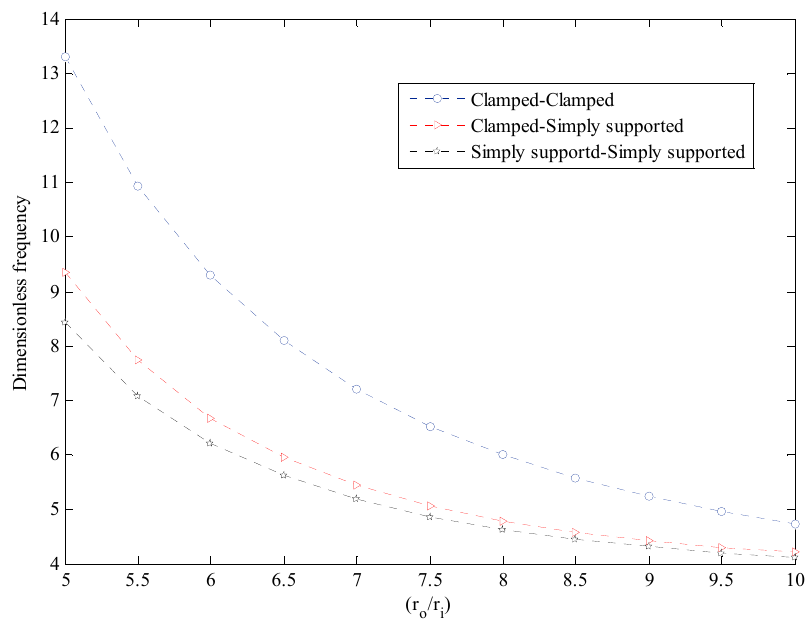
Figure 9. Dimensionless frequency versus radial ratio for different boundary conditions.